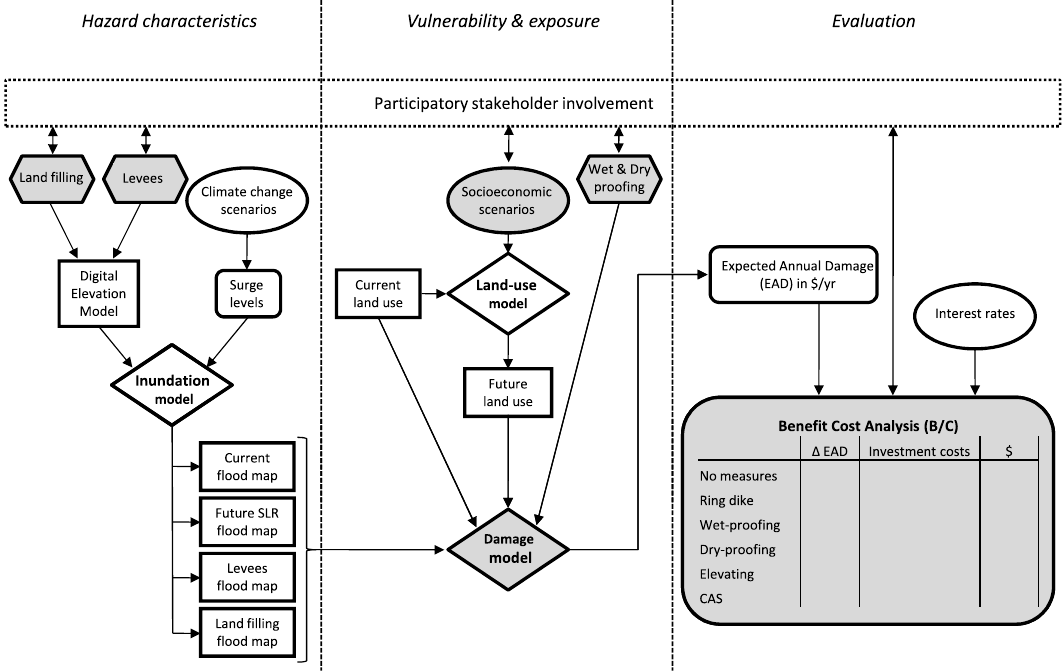
Figure 1. Overview of methods applied in this paper (filled shapes indicate use of participatory developed information, ovals are external scenarios, diamonds are models, squared boxes are maps, polygons are adaptation strategies, and rounded squared boxes are evaluation